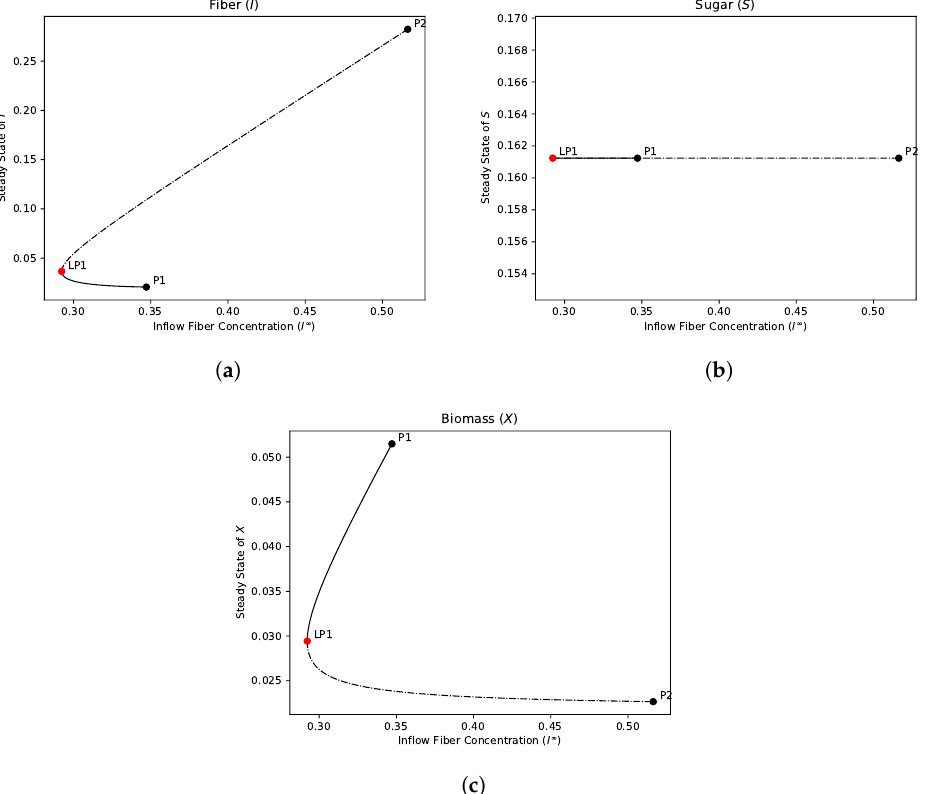
Figure 4. Bifurcation diagrams showing the steady states of ( a ) fiber ( I ∗ ( c ) biomass ( X ∗ ) as a function of inflow fiber concentration ( I ∞ ). The solid and dashed lines indicate 1,2 stable and unstable steady states, respectively. P1 and P2 refer to the start and end points of the continuation. LP1 is the limit